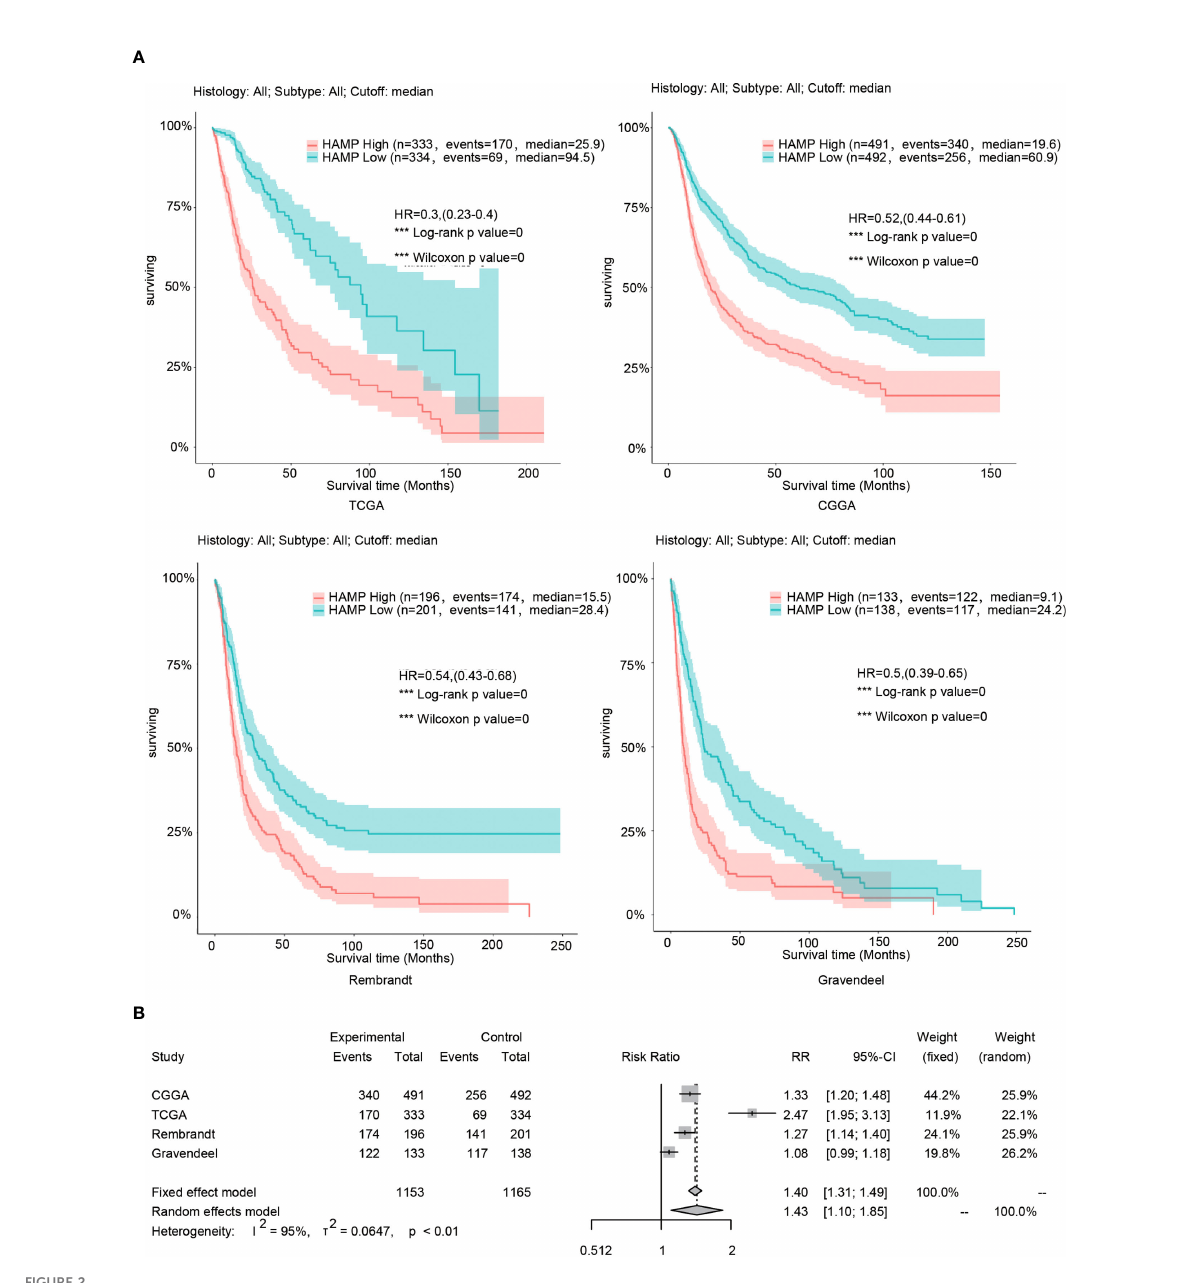
FIGURE 2 Analysis of the relationship between hepcidin and survival in glioma. (A) Kaplan – Meier plots of hepcidin in a variety of glioma datasets. The 95% con fi dence interval (CI) is shown. The patients were divided into high- and low-expression groups by the median expression level. (B) Forest plot of the risk ratio for patients with high hepcidin expression levels compared with patients with low hepcidin expression levels. ***p <